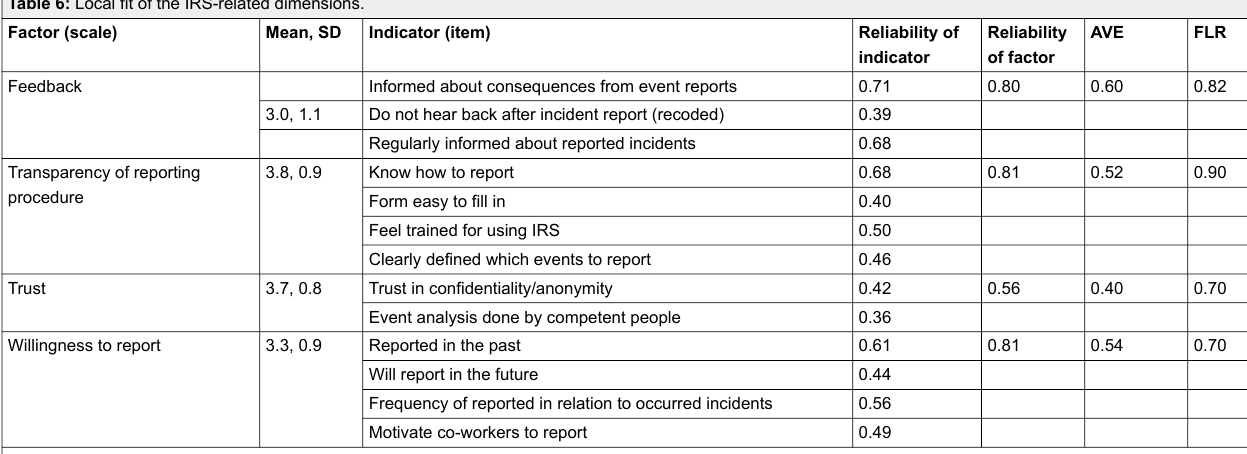
Table 6: Local fit of the IRS-related dimensions. Factor (scale) Mean, SD Indicator